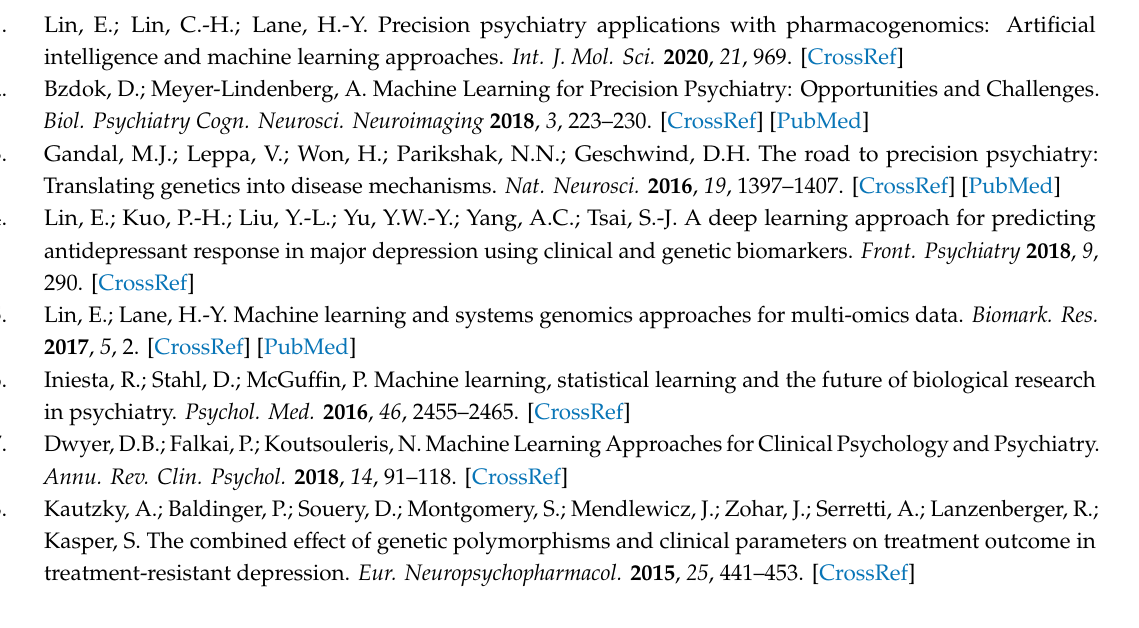
Table S1: The di ff erence in the means of AUC, sensitivity, and specificity for predicting treatment response between the boosting ensemble model with feature selection and other models including the boosting ensemble model, logistic regression, SVM, C4.5 decision tree, naïve Bayes, random forests, and MFNN models, Table S2: The di ff erence in the means of AUC, sensitivity, and specificity for predicting remission between the boosting ensemble model with feature selection and other models including the boosting ensemble model, logistic regression, SVM, C4.5 decision tree, naïve Bayes, random forests, and MFNN